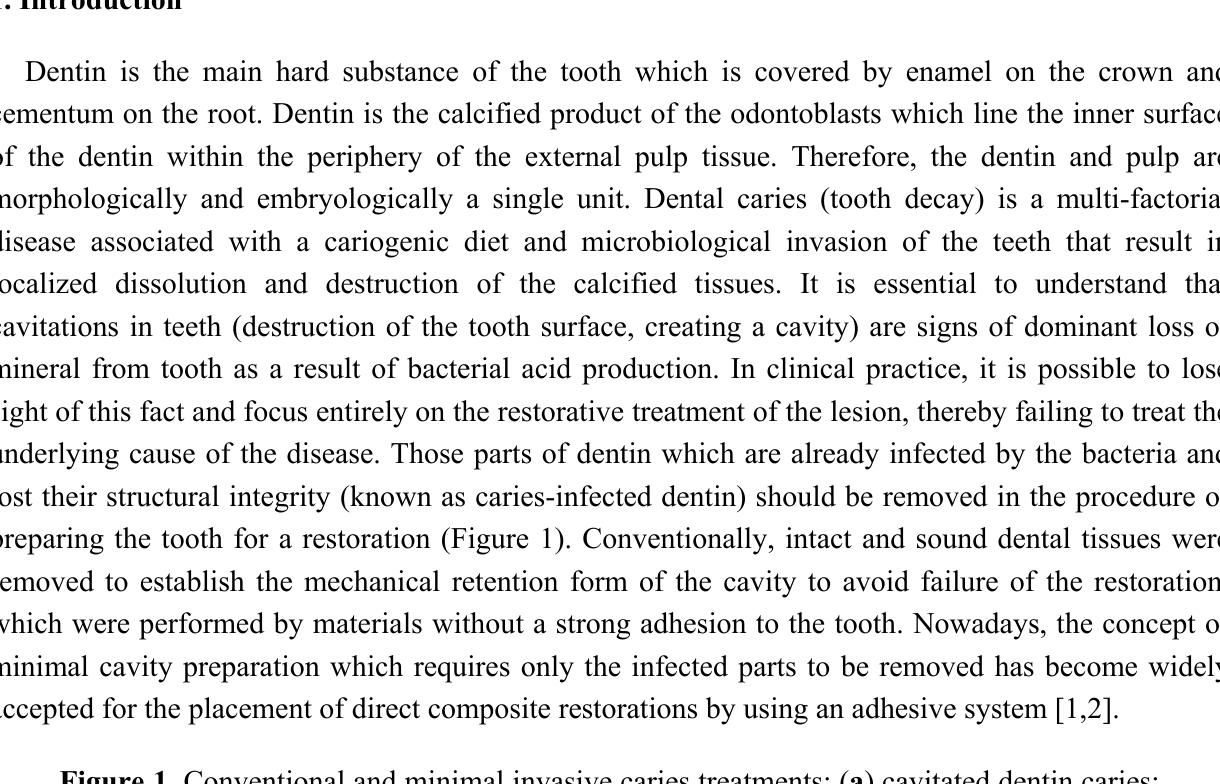
Figure 1. Conventional and minimal invasive caries treatments: ( a ) cavitated dentin